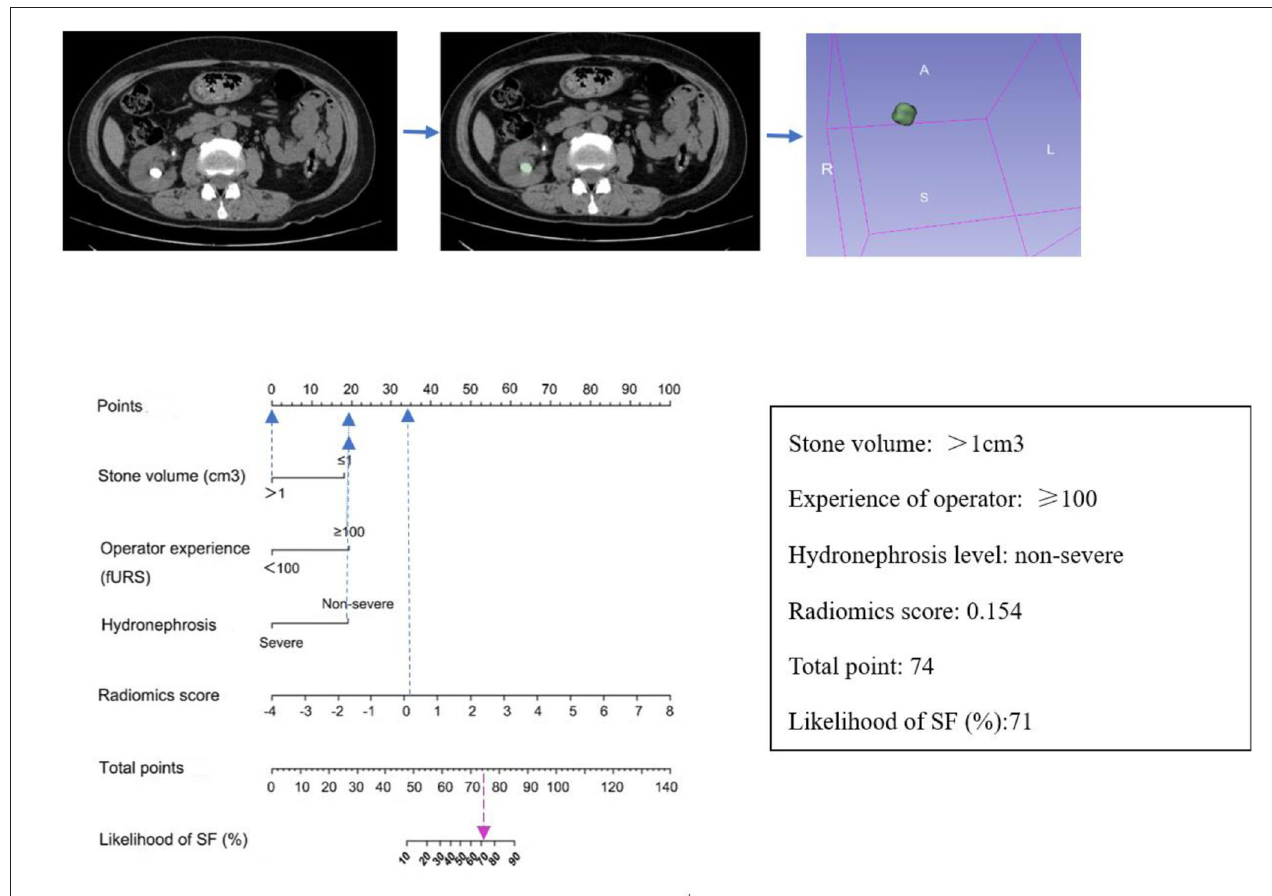
FIGURE 5 | An example of how to use the clinical–radiomics nomogram to predict SF status in a 58-year-old female patient with SF outcome after flexible ureteroscopy (fURS). Locate the patient’s Rad-score on the Rad-score axis. Draw a line straight upward to the points’ axis to determine how many points the patient receives for his or her Rad-score. Conduct a similar process for other indicators. Sum the points calculated for each of the risk factors and track down the added sum on the total points axis. Draw a line straight down to find the patient’s likelihood of